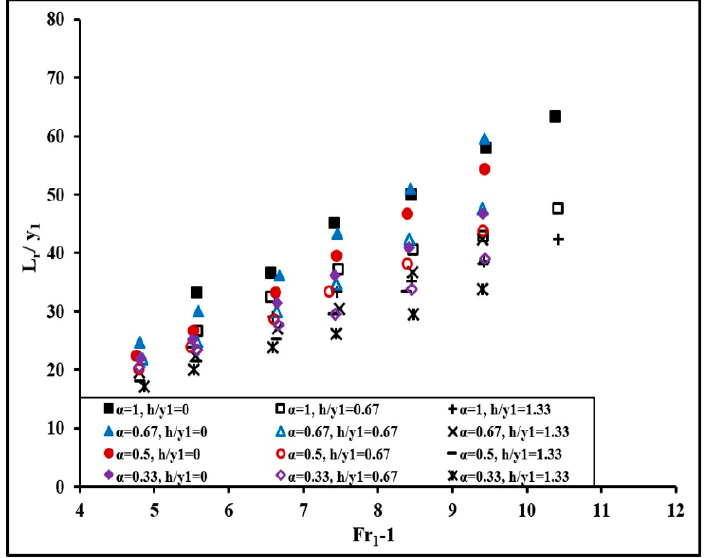
Figure 16. Relation between the ratio of L r / y 1 and ( Fr 1 − 1) for the experimental data of this research.